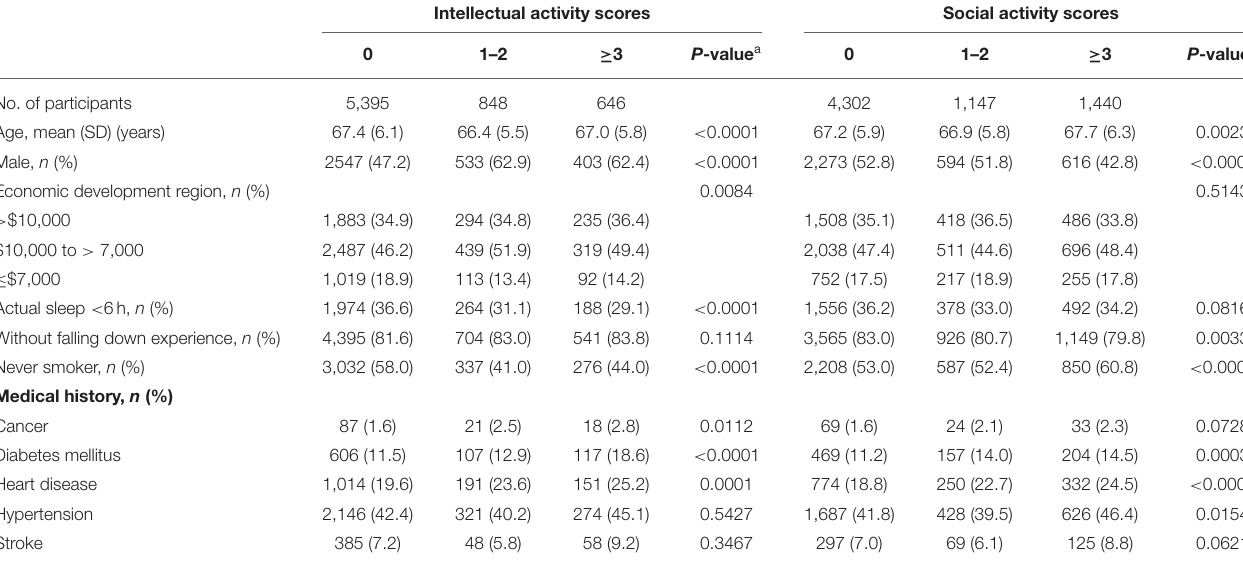
TABLE 1 | Baseline characteristics according to the intellectual activity and social activity scores.